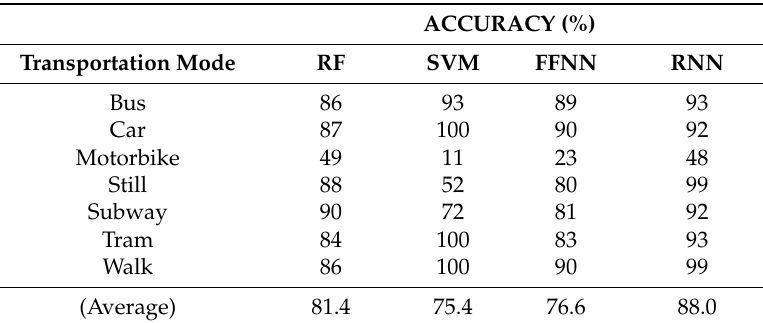
Table 4. Feature-based approaches